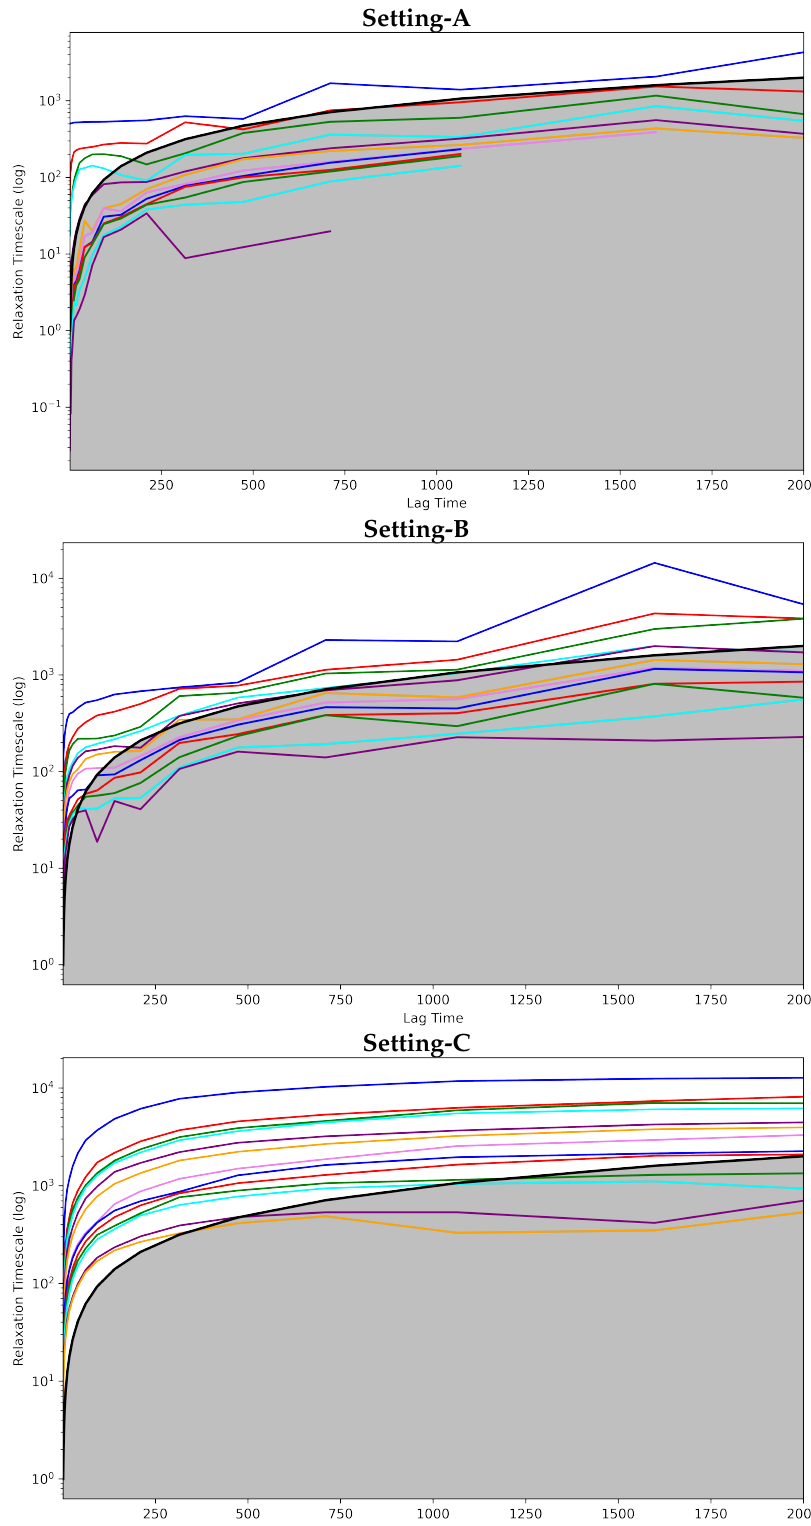
Figure 2. The Convergence Analysis test is carried out on each of the free-antibody MSMs obtained respectively from ( top panel) Setting-A, ( middle panel) Setting-B, and ( bottom panel) Setting-C. Each drawn curve shows the relaxation timescale of an MSM composed of s states, as s varies from 1 to the total number of states identified. The cutoff region (above which any curve representing a good discretization of the state space should be) is shown in